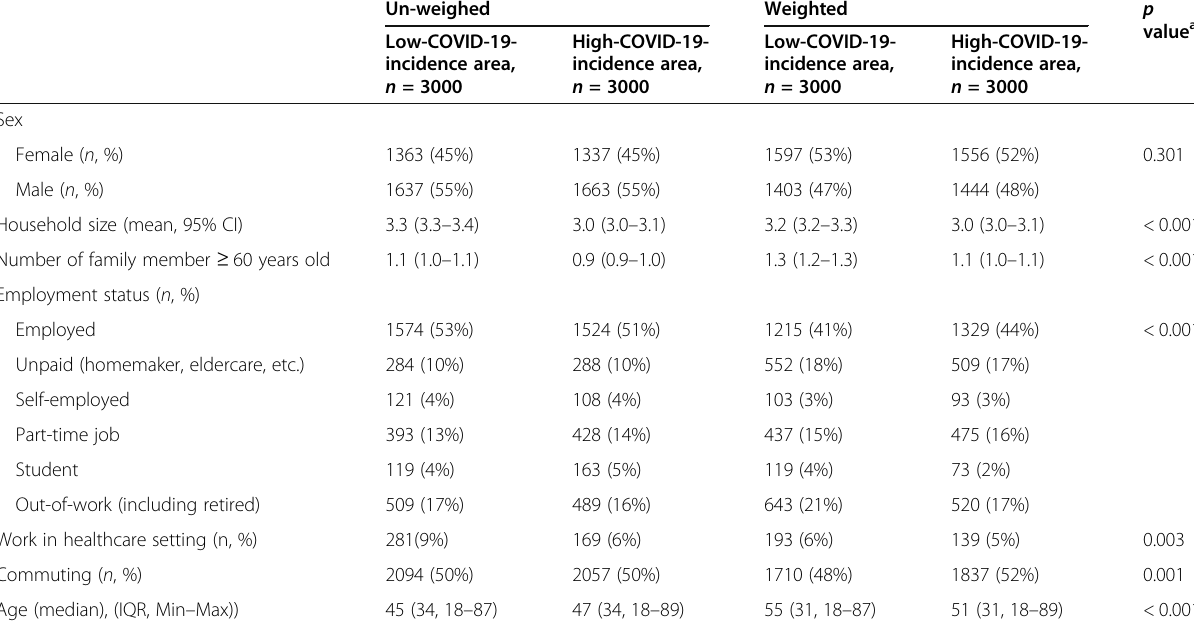
Table 2 Characteristics of respondents by study area (un-weighted and weighted)